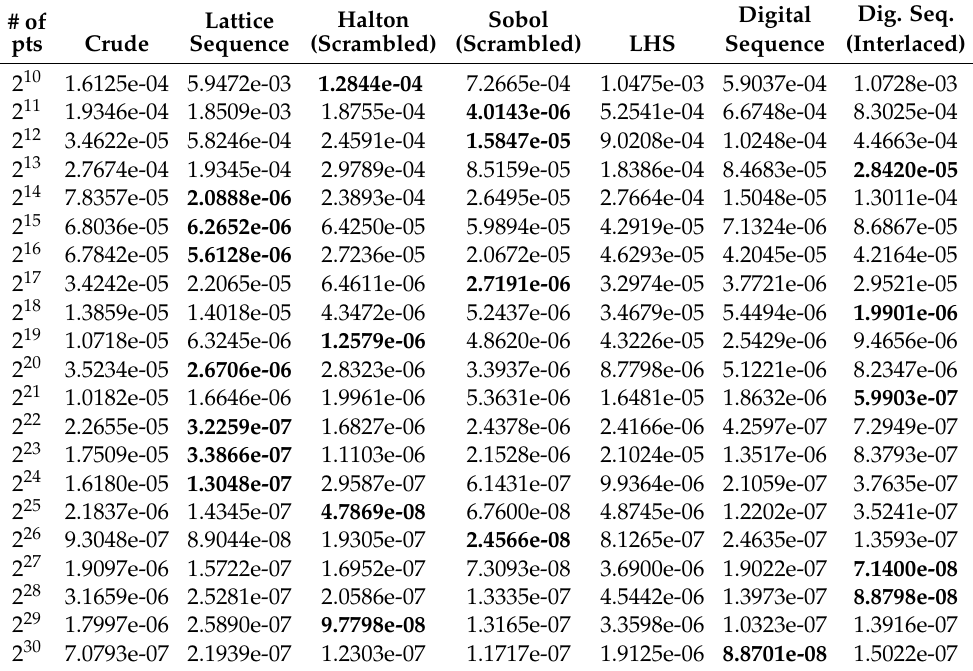
Table 1. The 10-dimensional integral absolute